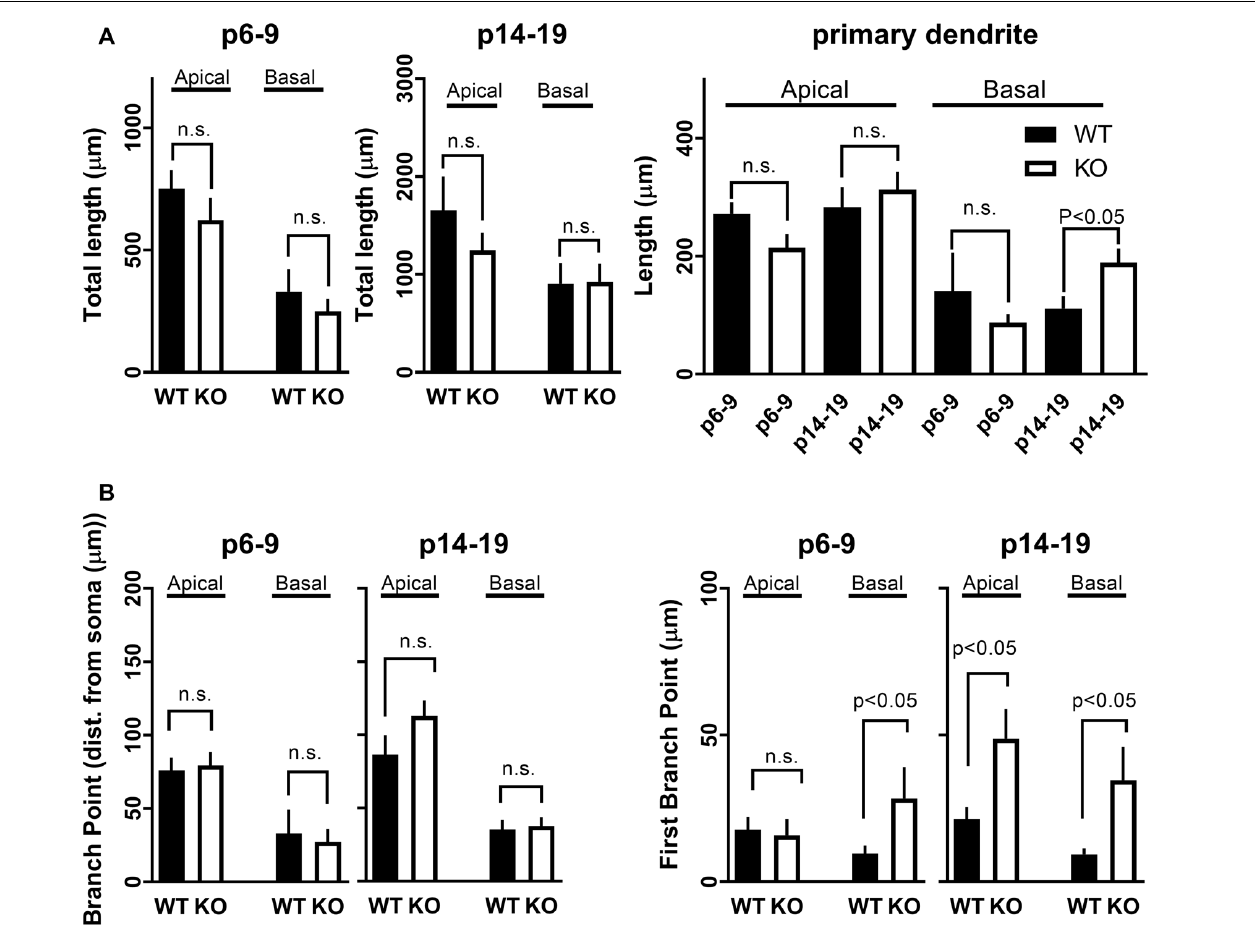
FIGURE 6 | Development of dendritic branches in CA1 pyramidal neurons in FMRP KO mice. (A) Total length of dendritic branches in CA1 neurons either WT (black bars) or FMRP KO (white bars). The length of apical or basal dendrites was measured in slices either P6–9 (left) or slice P14–19 (right). The Student’s t -test shows no significance between WT and FMRP KO neurons within the different age groups or types of the dendrite. (Right) Length of dendritic branches broken down into primary dendrite from CA1 neurons as indicated. (B) Distance from soma to average all (left) or first (right) branching point in CA1 neurons from either WT (black bars) or FMRP KO (white bars) from slices P6–9 or slices P14–19 as indicated in Figure. The Student’s t -test shows significance ( p < 0.05) between WT and FMRP KO neurons within the different age groups for the first branch point. n.s.: not